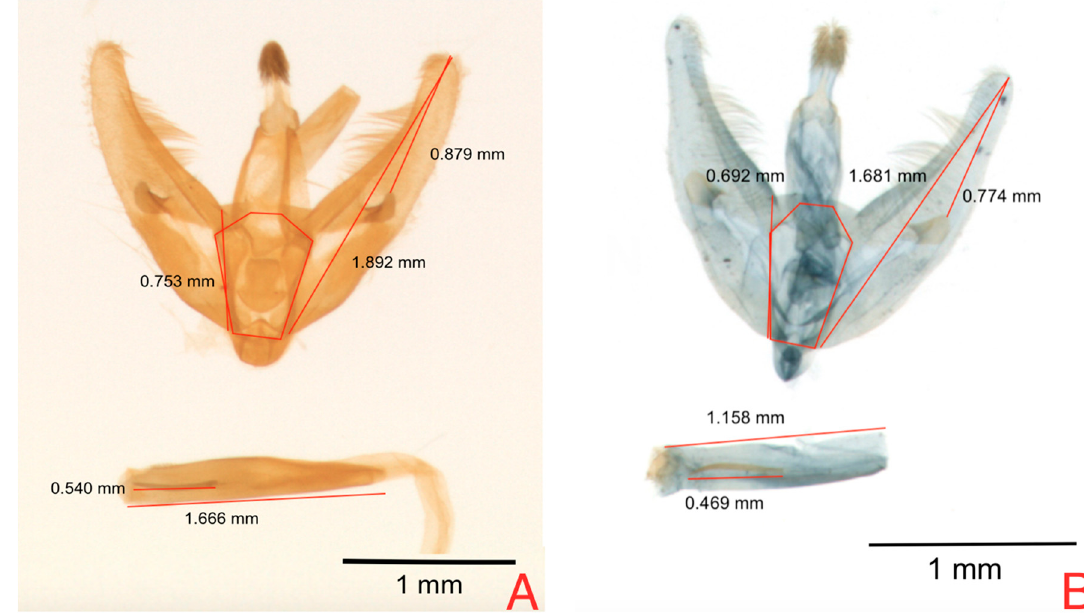
Figure 4. Morphometric differences in male genitalia of N. elegantalis from two Solanaceous hosts; ( A ) naranjilla ( S. quitoense ); and ( B ) tree tomato ( S. betaceum ). Table 3. Decision criteria for the multivariate variance analysis (MANOVA) in the metrics of male genitalia of N. elegantalis . Source of Variation GL Pillai Criteria Approx F Pr (>F)